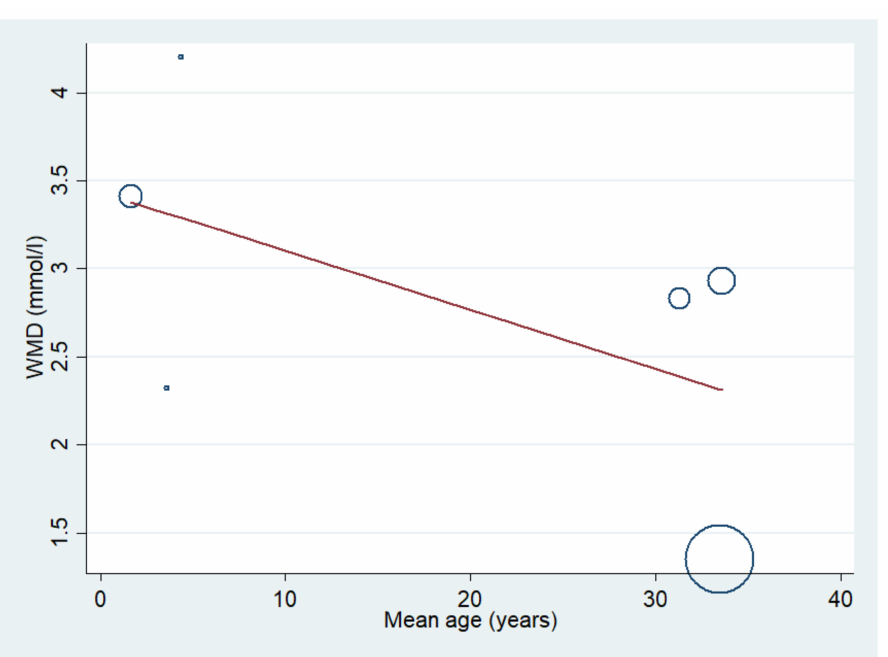
Figure 11. Lactate levels in patients with severe malaria who died and those who survived using mean age as a covariate. Circles and dots show the WMD of individual studies. Abbreviations: WMD, weighted mean difference; CI, confidence interval.